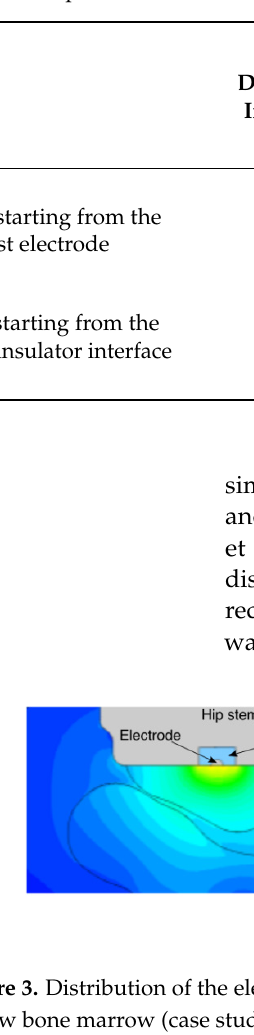
Table 1. Electric potential measured on the cross-section of the bone perpendicular to the first electrode and the interface between implant and insulator.